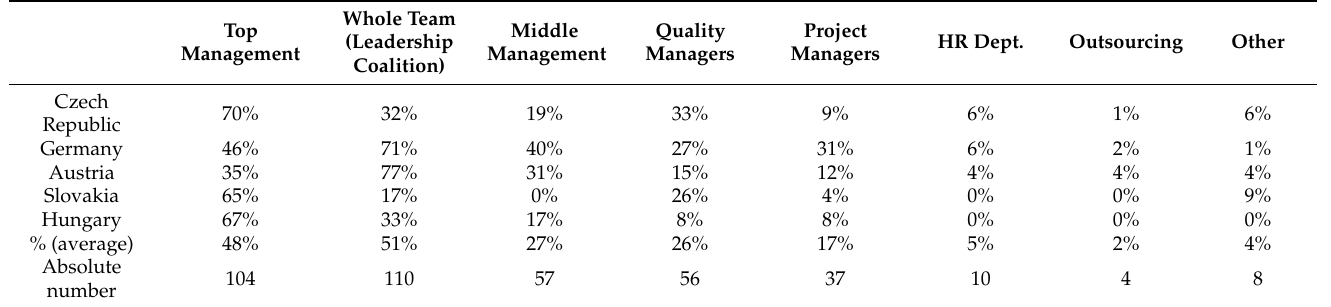
Table 7. Who is responsible for change implementation and management in the hospital.